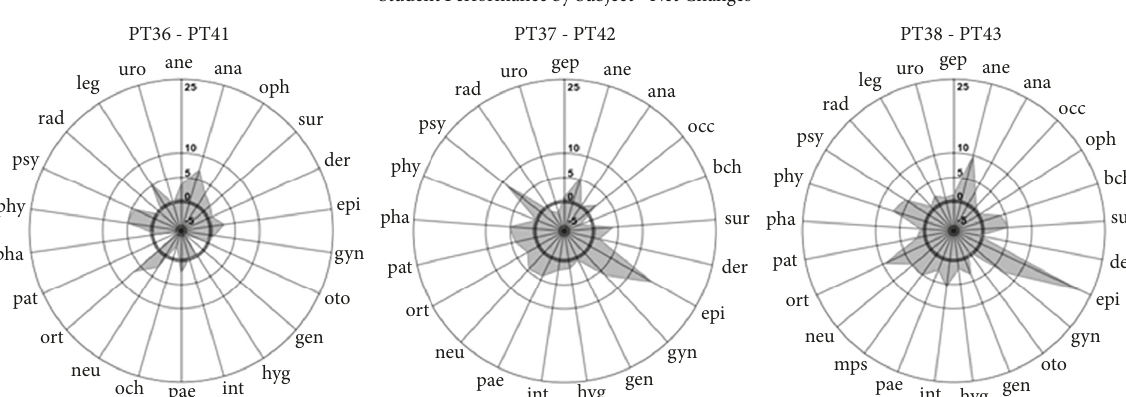
Figure 4: Radar charts showing variations in the percentage share of correct answers within each PTpair disaggregated by subject. Every PT shares a considerable number of questions with the PT that took place five semesters before. Data for these charts were collected from tests that took place from April 2017 to December 2020 (36 � summer semester 2017, 37 � winter semester 2017/18, 38 � summer semester 2018; 2021. Axis labels refer to absolute changes in percentage shares, with the thicker black circumference corresponding to 0% (no change). For every PT pair, only medical disciplines with at least two associated questions are featured in the corresponding graph. PT, Progress